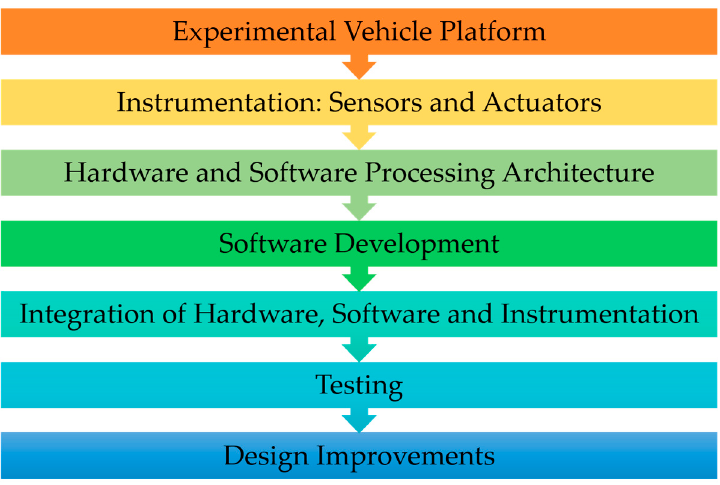
Figure 2. Research and development methodology.